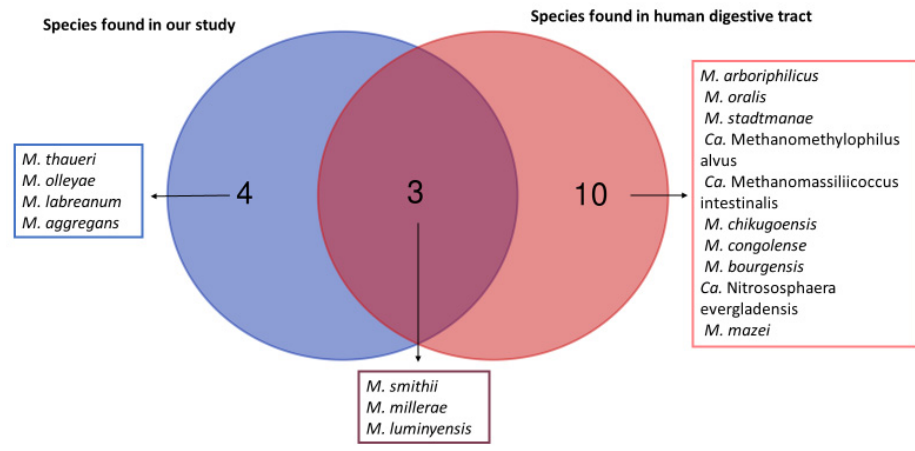
Figure 1. Venn diagram between the methanogens found in our study and those known from the human digestive tract. This Venn diagram shows which species of methanogens are found in common in humans and in animal samples analyzed in this study and which species of methanogens are found exclusively in animals and exclusively in humans.